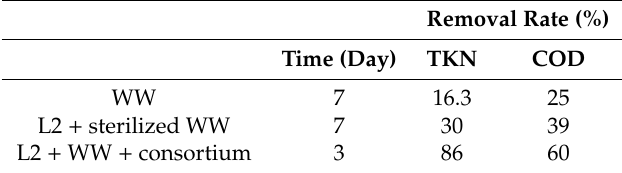
Table 4. Nannochloropsis gaditana L2 improvement in TKN and COD removal rates.